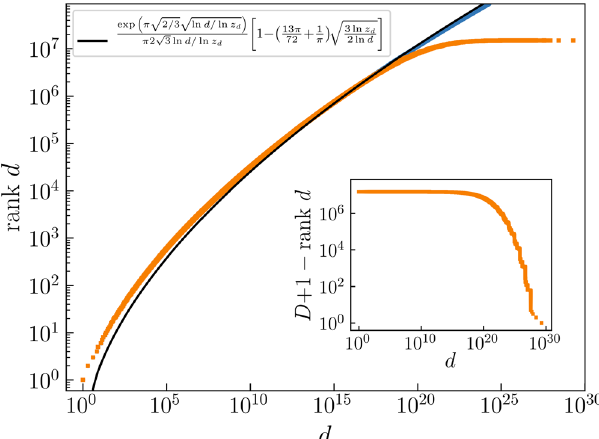
FIG. 7. Number of distinct degeneracies less than or equal to d versus d . Inset: Number of different degeneracies higher than or equal to d versus d . The orange square symbols are full results for n ¼ 120 . The circular blue symbols are values calculated in the limit n → ∞ as described in Sec. VI. Solid black curve is the asymptotic approximation Eq.